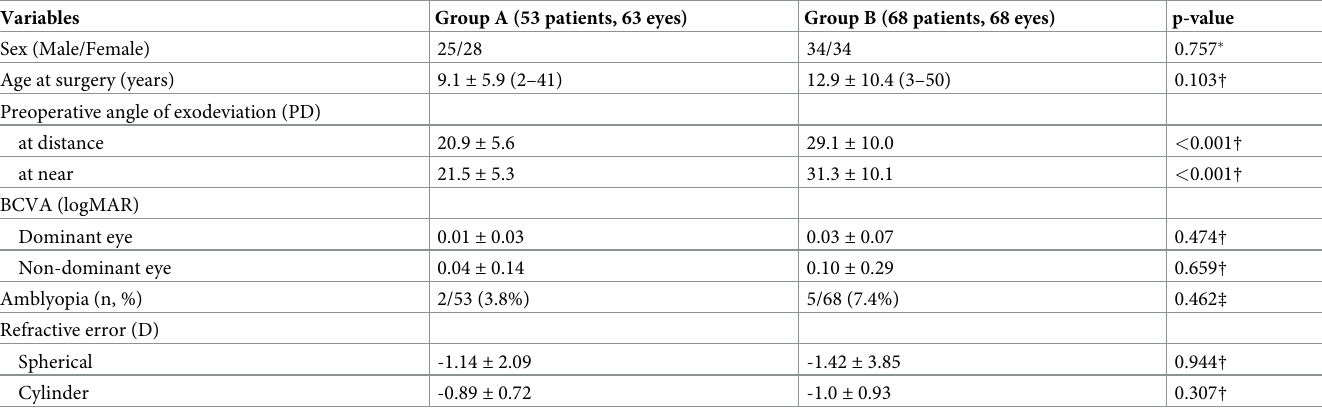
Table 2. Preoperative demographic data.